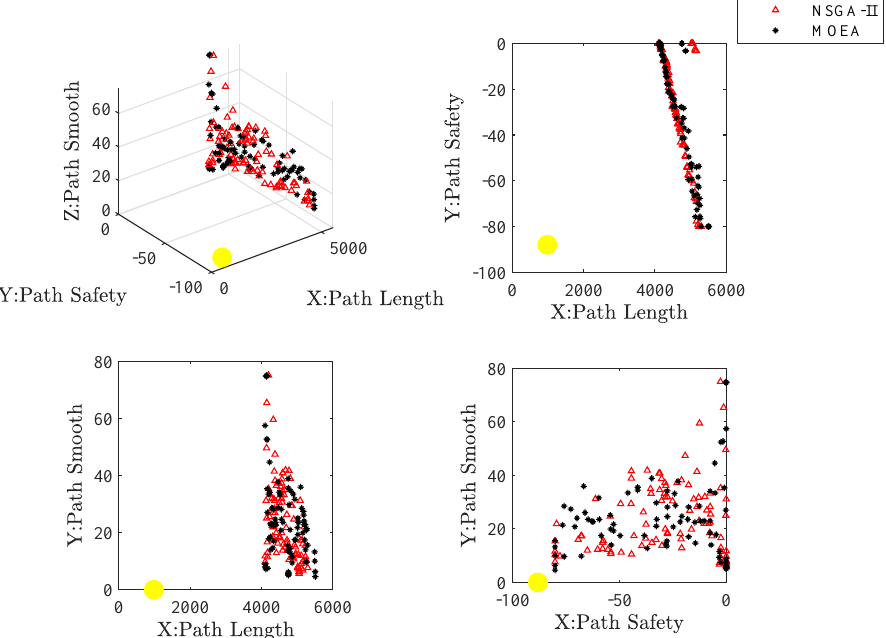
Figure 26. Based on Figure 11D, the approximate Pareto fronts generated by the two algorithms NSGA-II and MOEA. The sub-figure of the upper left corner shows the image of the approximate Pareto front in three-dimensional space. The remaining three sub-figures are the projections of the approximate Pareto front in the two-dimensional